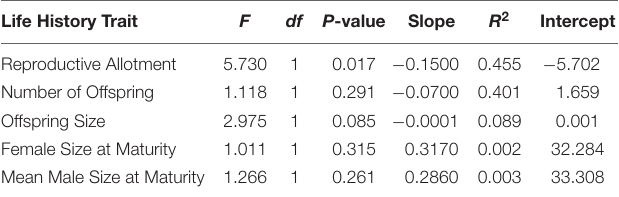
TABLE 3 | Statistical tests for effect of predation environments on the five life history